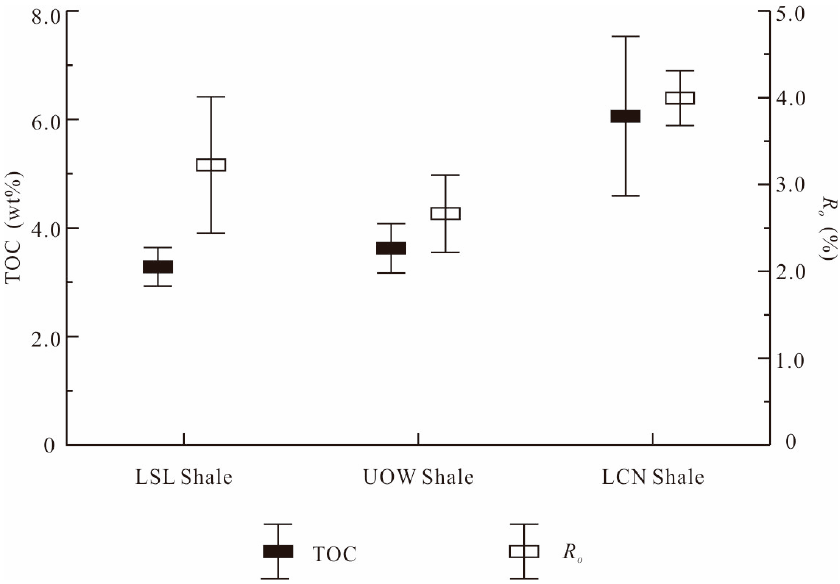
Figure 8. A comparison of TOC and R o among the studied shales.